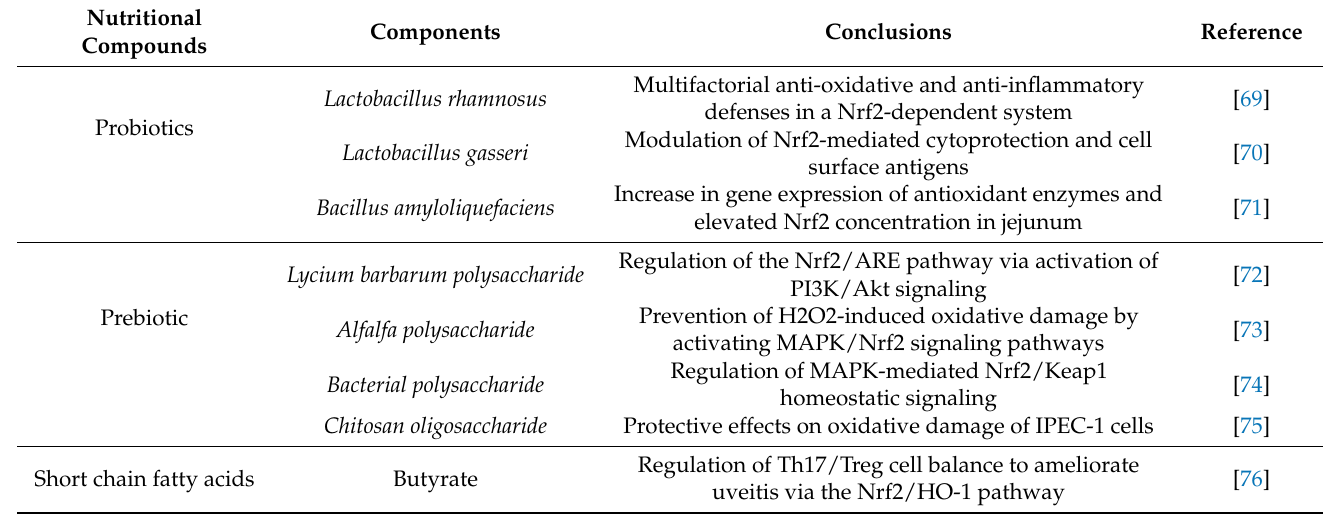
Table 1. Modulation of Nrf2/ARE signaling pathways by nutritional components. Nutritional